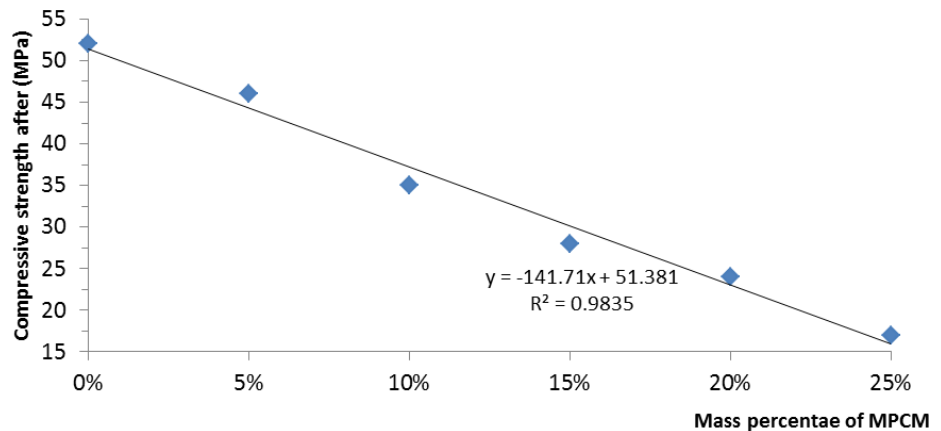
Figure 17. Relationship between the compressive strength and mass percentage of MPCM.